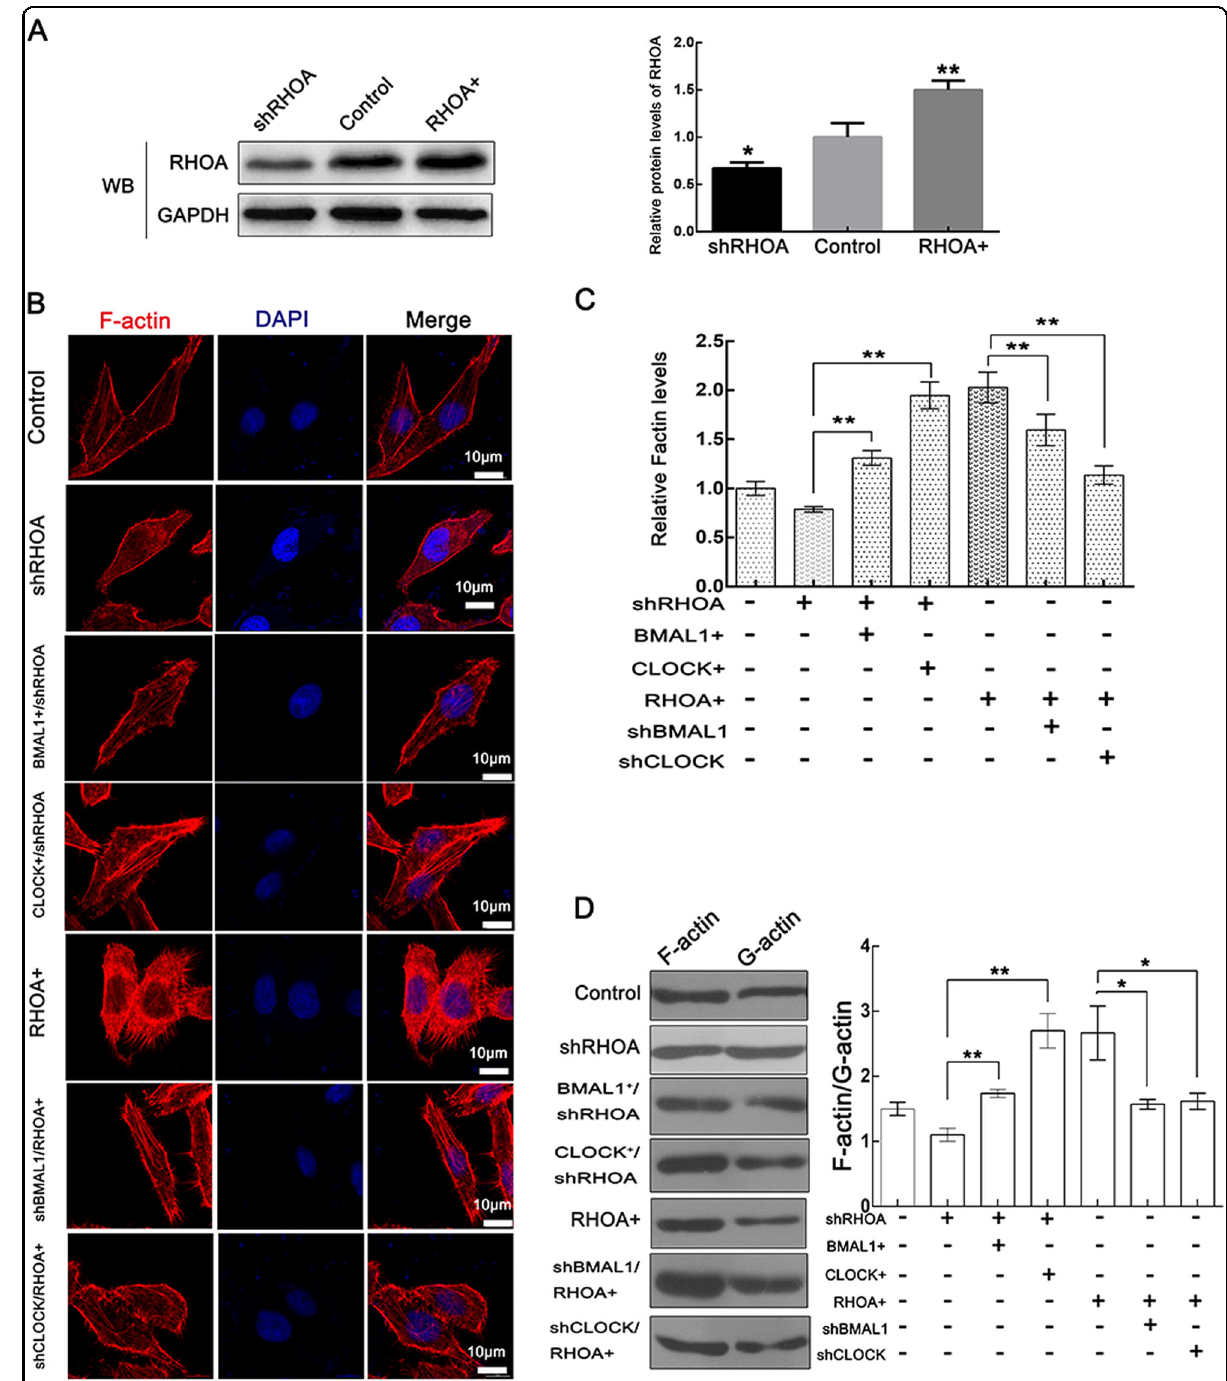
Fig. 6 CLOCK and BMAL1 enhance F-actin fi laments via the RHOA-ROCK-CFL pathway. a RHOA abundance was veri fi ed by western blotting in RHOA overexpression (RHOA + ), RHOA knockdown (shRHOA), and control HeLa cells. GAPDH was used as a loading control. Data are presented as the mean ± sd ( n = 3); * p < 0.05; ** p < 0.01. b , c F-actin was stained with TRITC-phalloidin (Red) in HepG2 cells transfected with vectors. Nuclei were stained with DAPI. The scale bars represent 10 μ m. The F-actin levels were quanti fi ed with the fl uorescence intensity ratio using ImageJ. The fl uorescence intensity of the control was taken as 1. Data were analyzed using a t test ( n = 3) and presented as the mean ± sd; * p < 0.05; ** p < 0.01. d F-actin and G-actin from HeLa cells were segmented by ultraspeed centrifugation and analyzed by western blotting using an antibody against β -actin. The data were quanti fi ed using ImageJ. * p < 0.05; ** p < 0.01, n.s. not signi fi